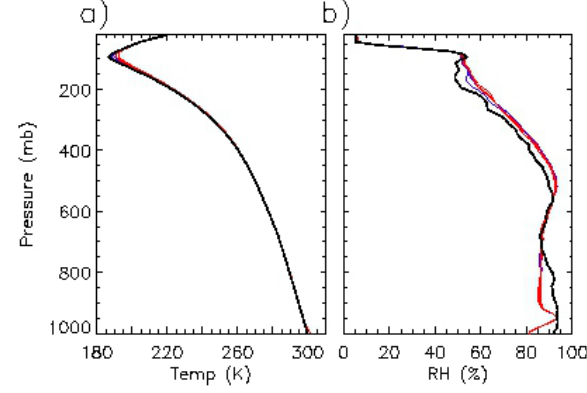
Fig. 6. Horizontally-averaged profiles of (a) temperature and (b) RH for the three low-OLR realizations (blue) and the three high- OLR realizations (red) averaged between 12;00UTC 19 January to 12:00UTC 25 January. Observations are shown by the black line.